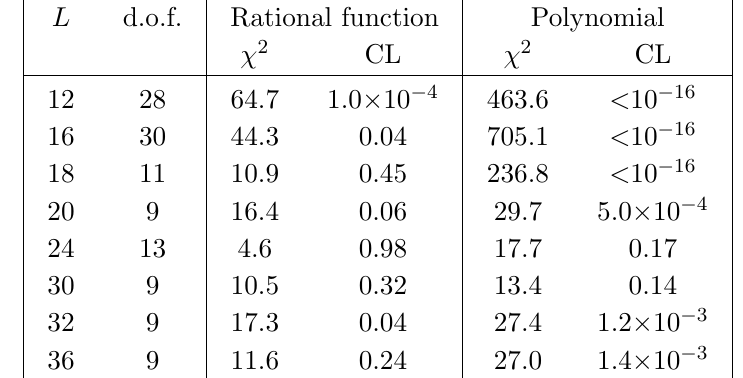
Table 24 . Quality of c = 0 : 25 renormalized coupling interpolations and columns as in table 23.